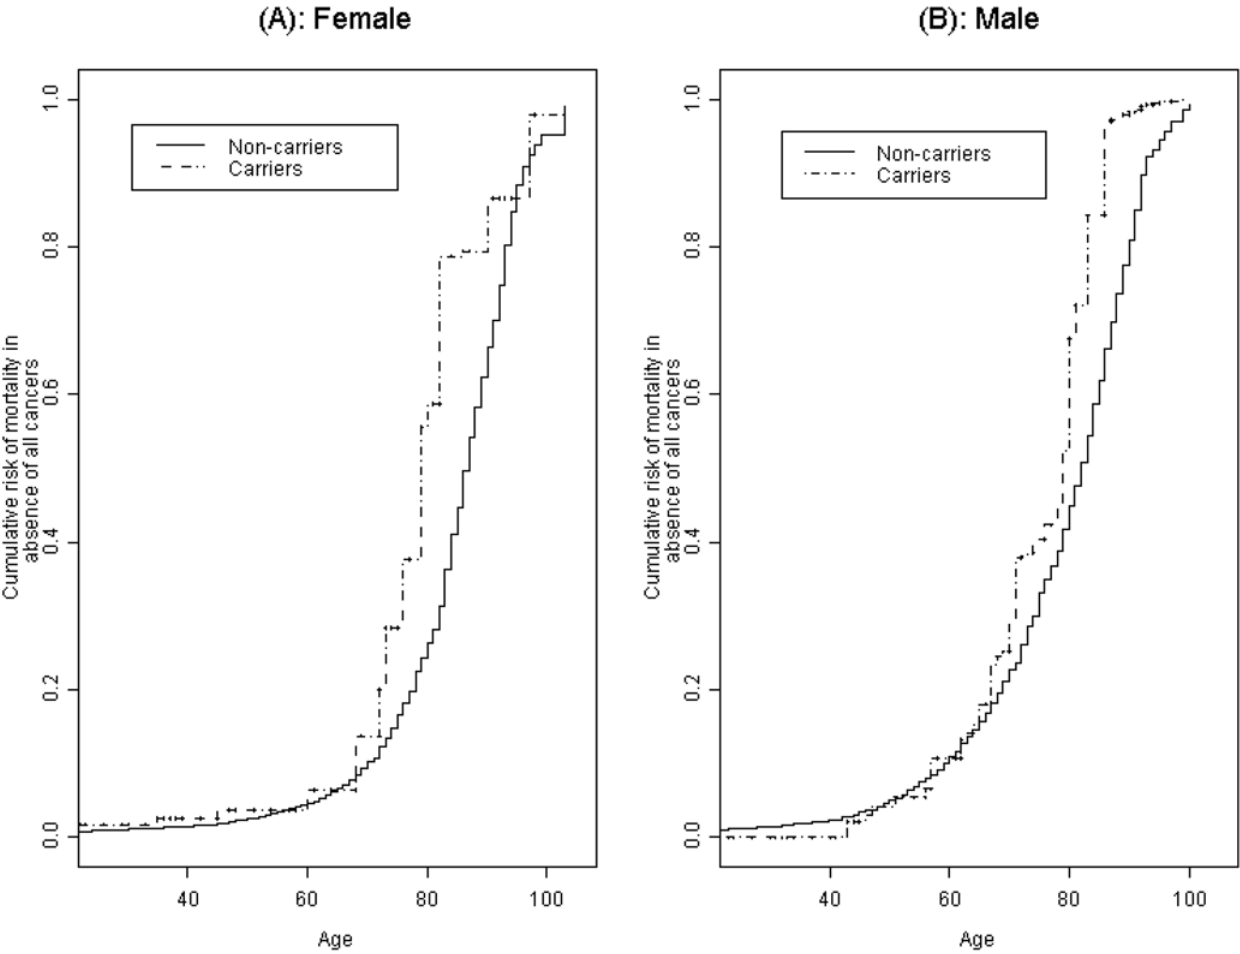
Figure 3. Estimated cumulative risk of mortality in the absence of any cancer. The figure shows the estimated cumulative risk of mortality in the absence of any cancer among females (panel A) and males (panel B).